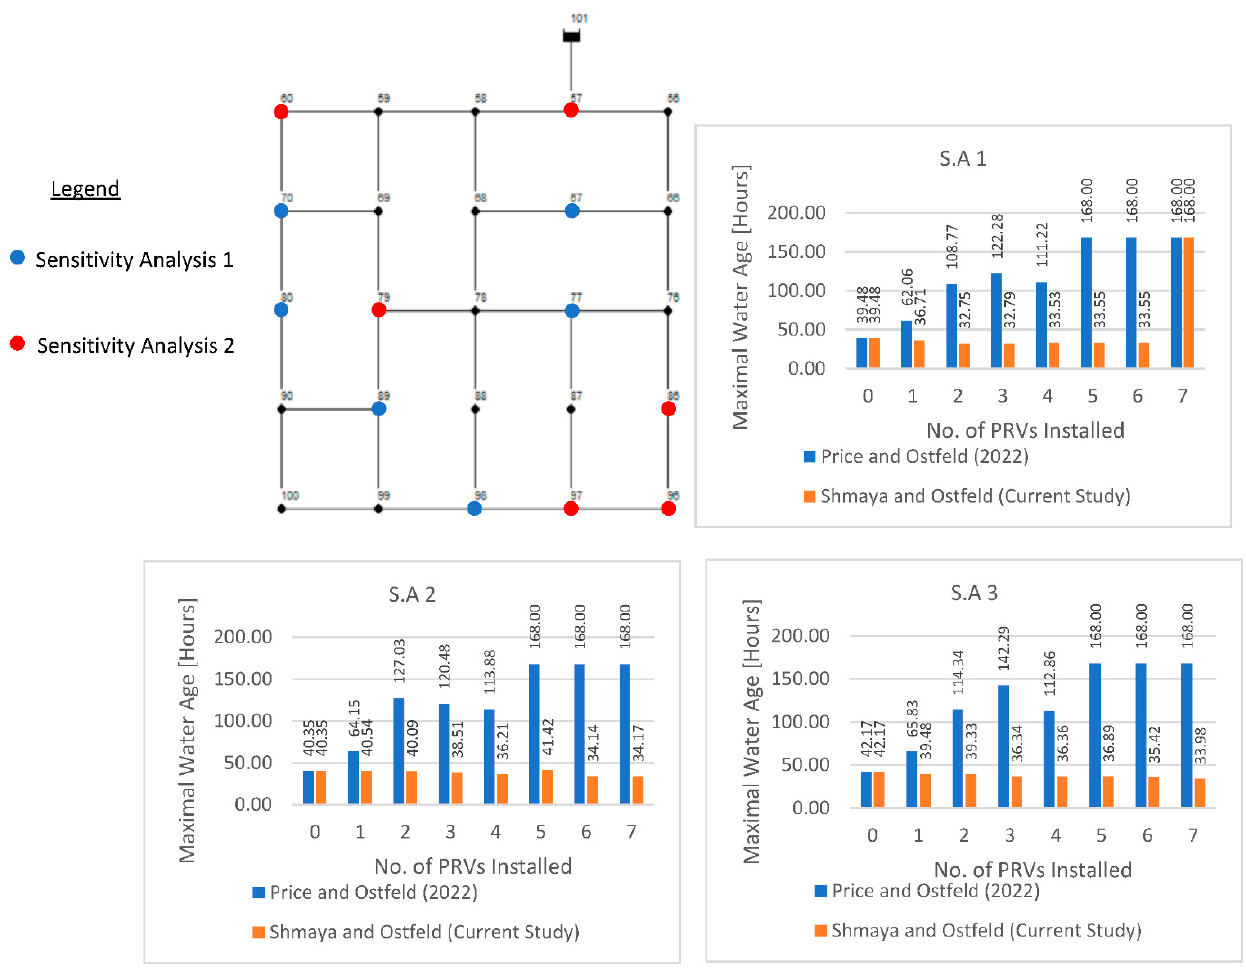
Figure 6. Sensitivity analysis results for the synthetic network. The modifications are shown in ( top left ). The results for scenario one are shown in ( top right ), for scenario two in ( bottom left ) and for scenario three in ( bottom right ).